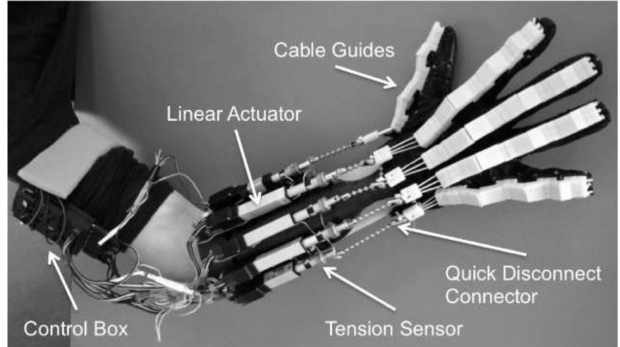
Figure 6. Close-up view of the portable, actuated glove-orthosis